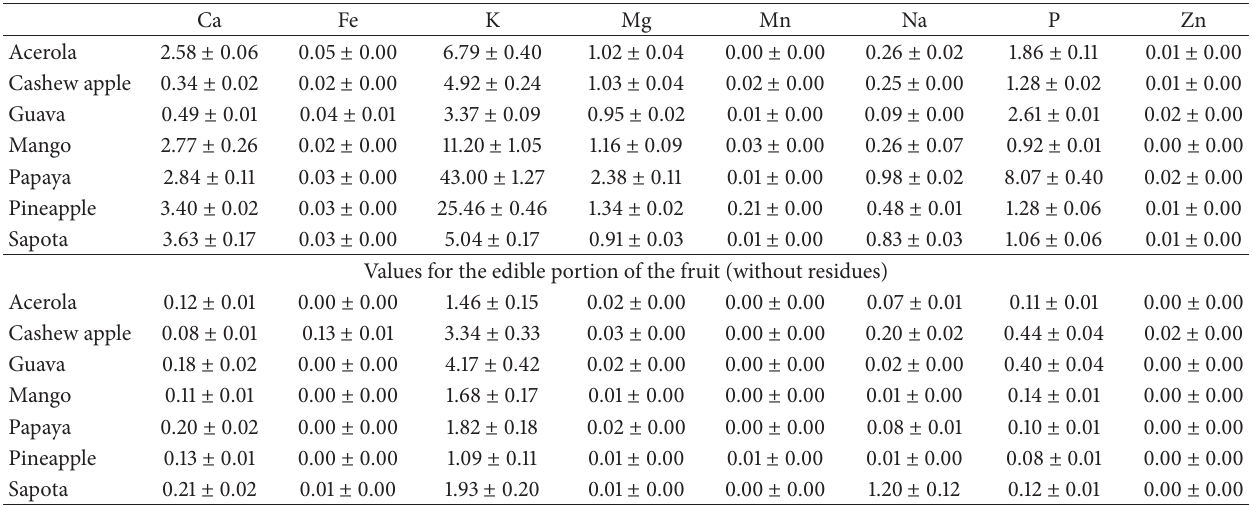
Table 5: Mineral content in fruit residues (mg/g).